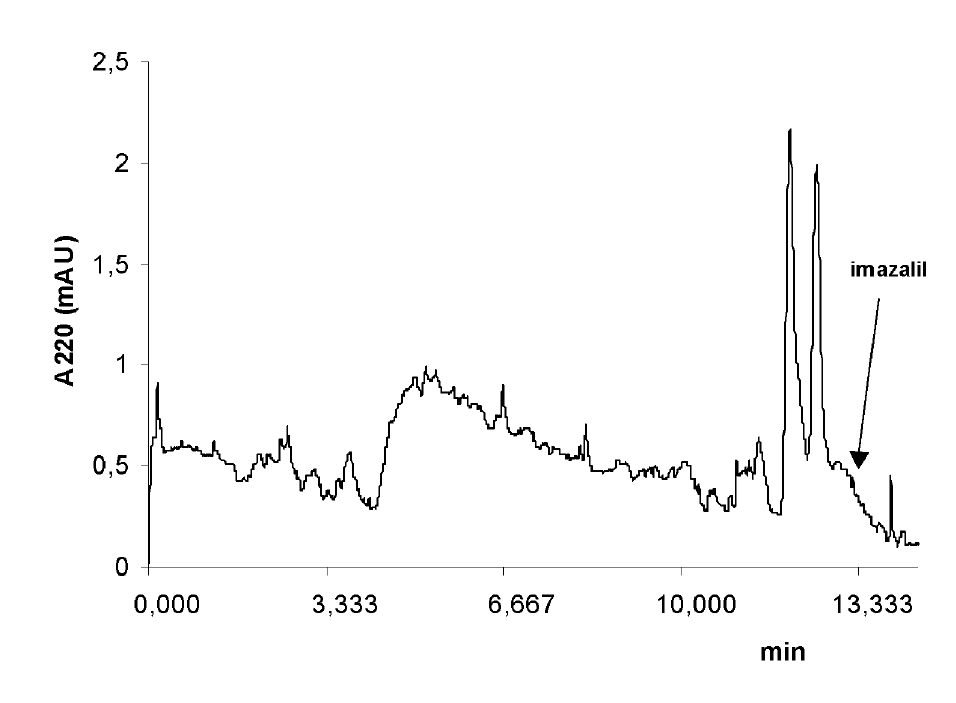
Fig. 3 Electropherogram of apple extract (not exposed with